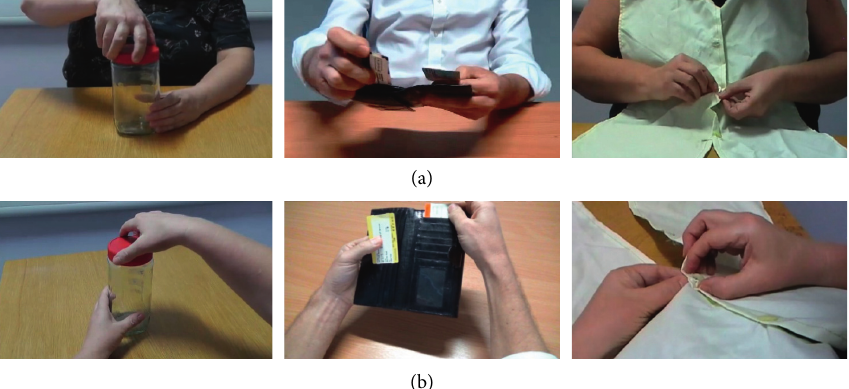
Figure 2: Examples of everyday actions used in the intervention (coffee jar, ticket sorting, and buttoning). Each action is presented from the third-person perspective (a) followed by the first-person perspective